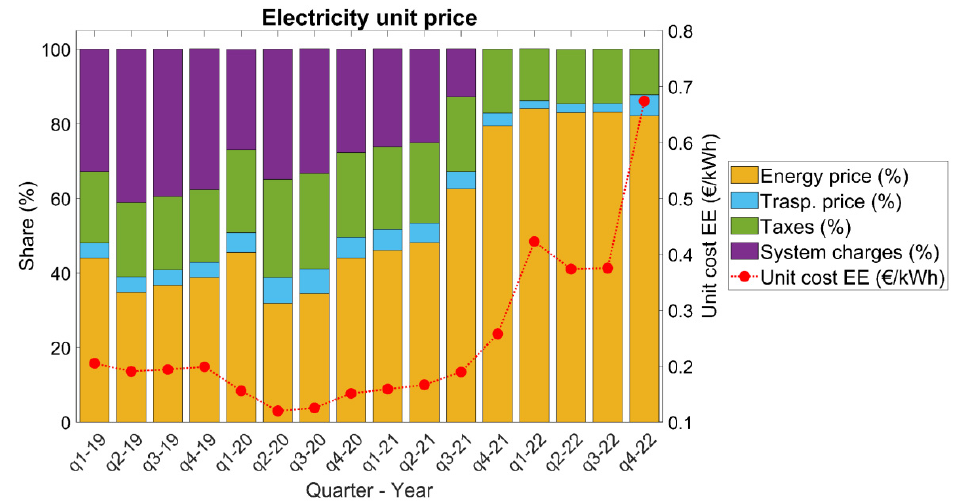
Figure 5. Unit electricity price (EUR/kWh) and price component share (%), period of 2019–2022.